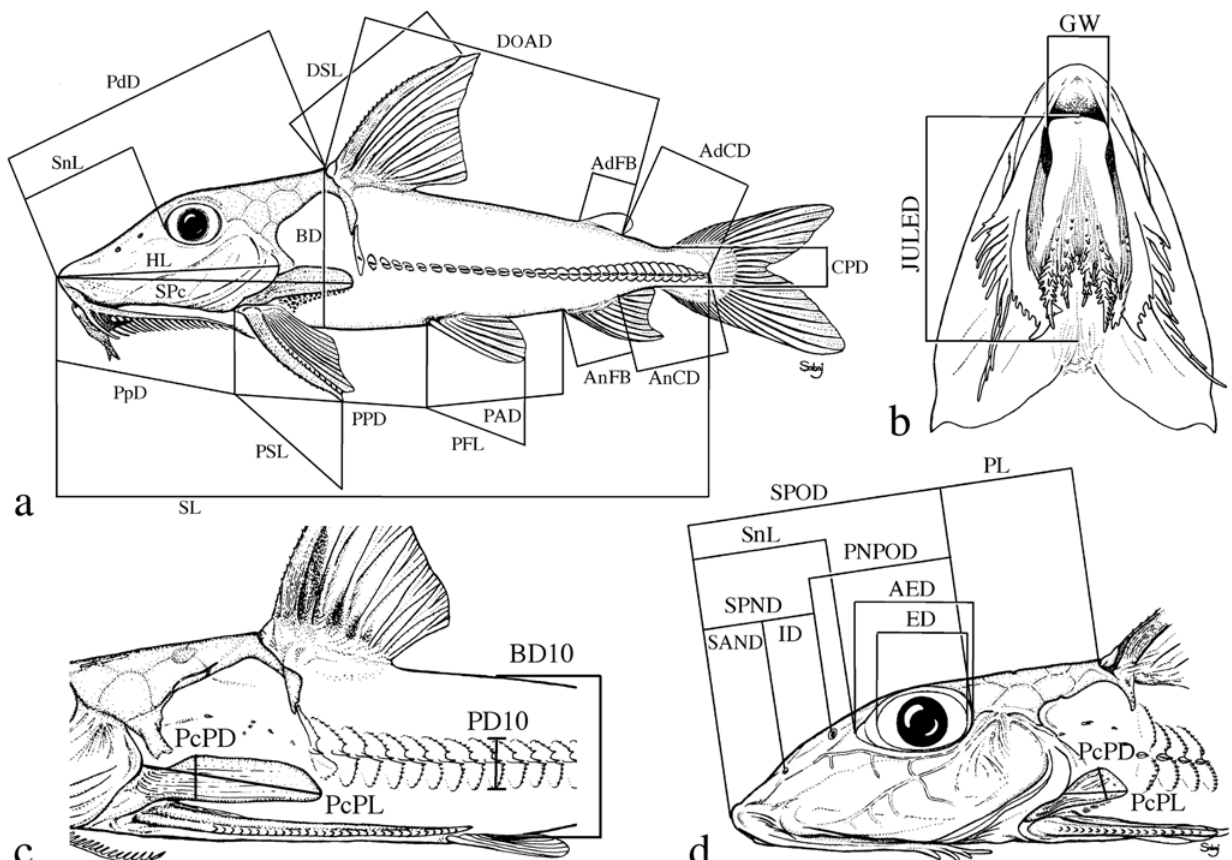
Fig. 2. Landmarks and measurements used for morphometric analysis (shown on generalized doradids). See Material and Methods for explanations of